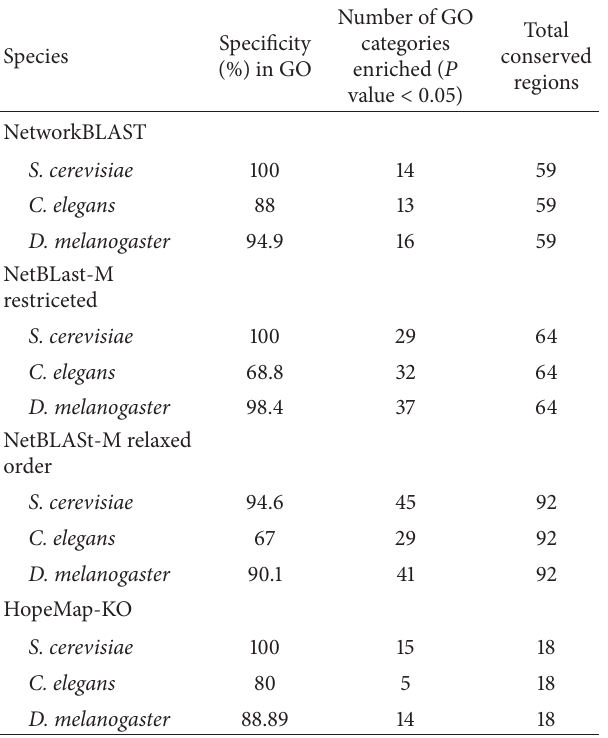
Table 7: A comparison of networkBLAST, NetworkBLAST-M, and HopeMap for yeast/fly/worm .